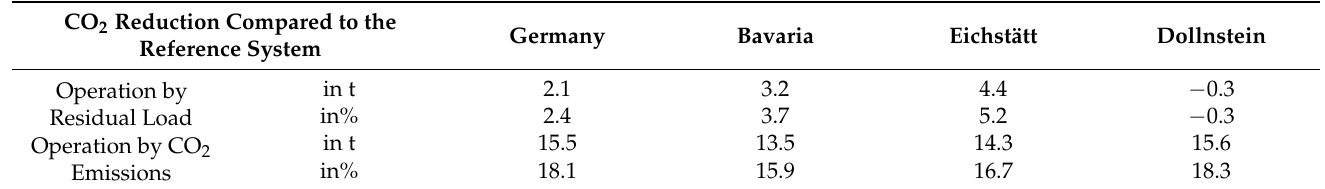
Table 6. Reduction of CO 2 emissions compared to the reference system by considering the residual load and the CO 2 emissions of the electricity